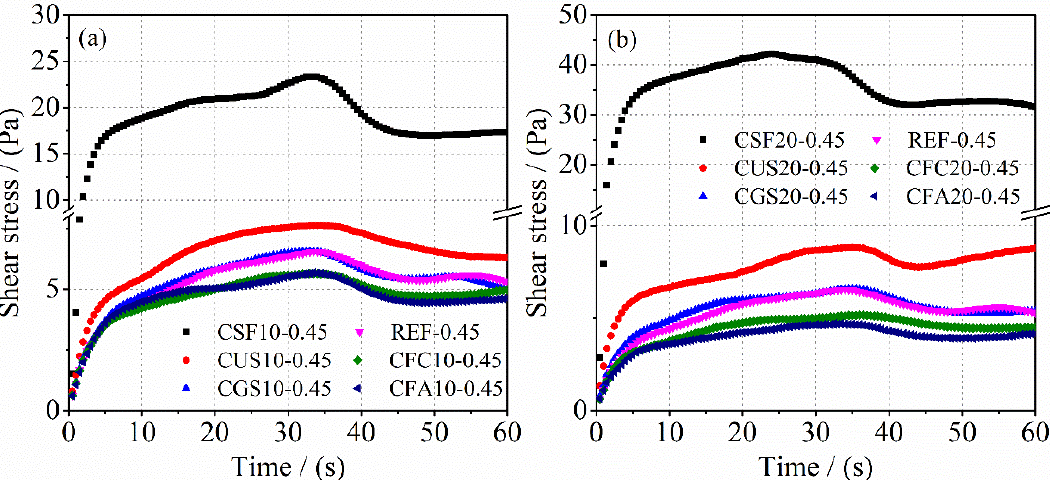
Figure 3. The change of shear stress of common pastes with time at the initial stage: ( a ) 10%, ( b ) 20%.